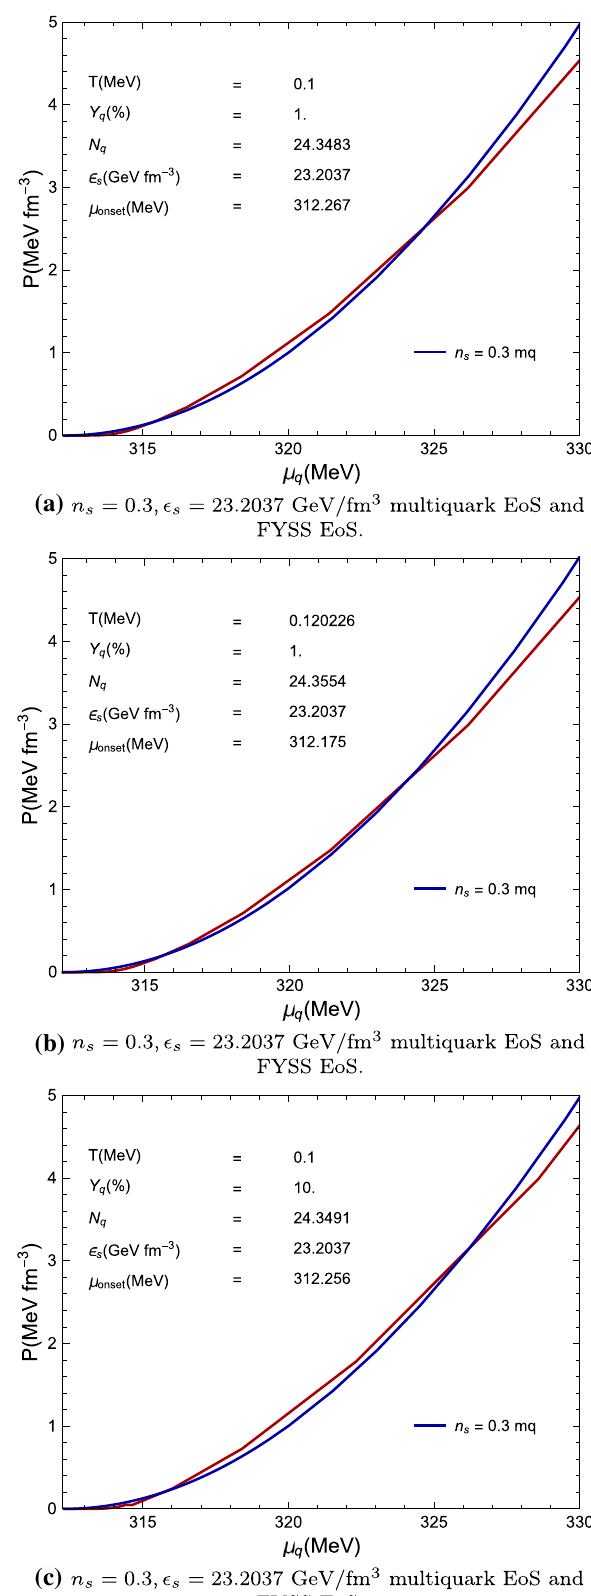
Fig. 6 P − μ plots comparing the multiquark and baryonic nuclear phases at moderate temperatures and proton-baryon